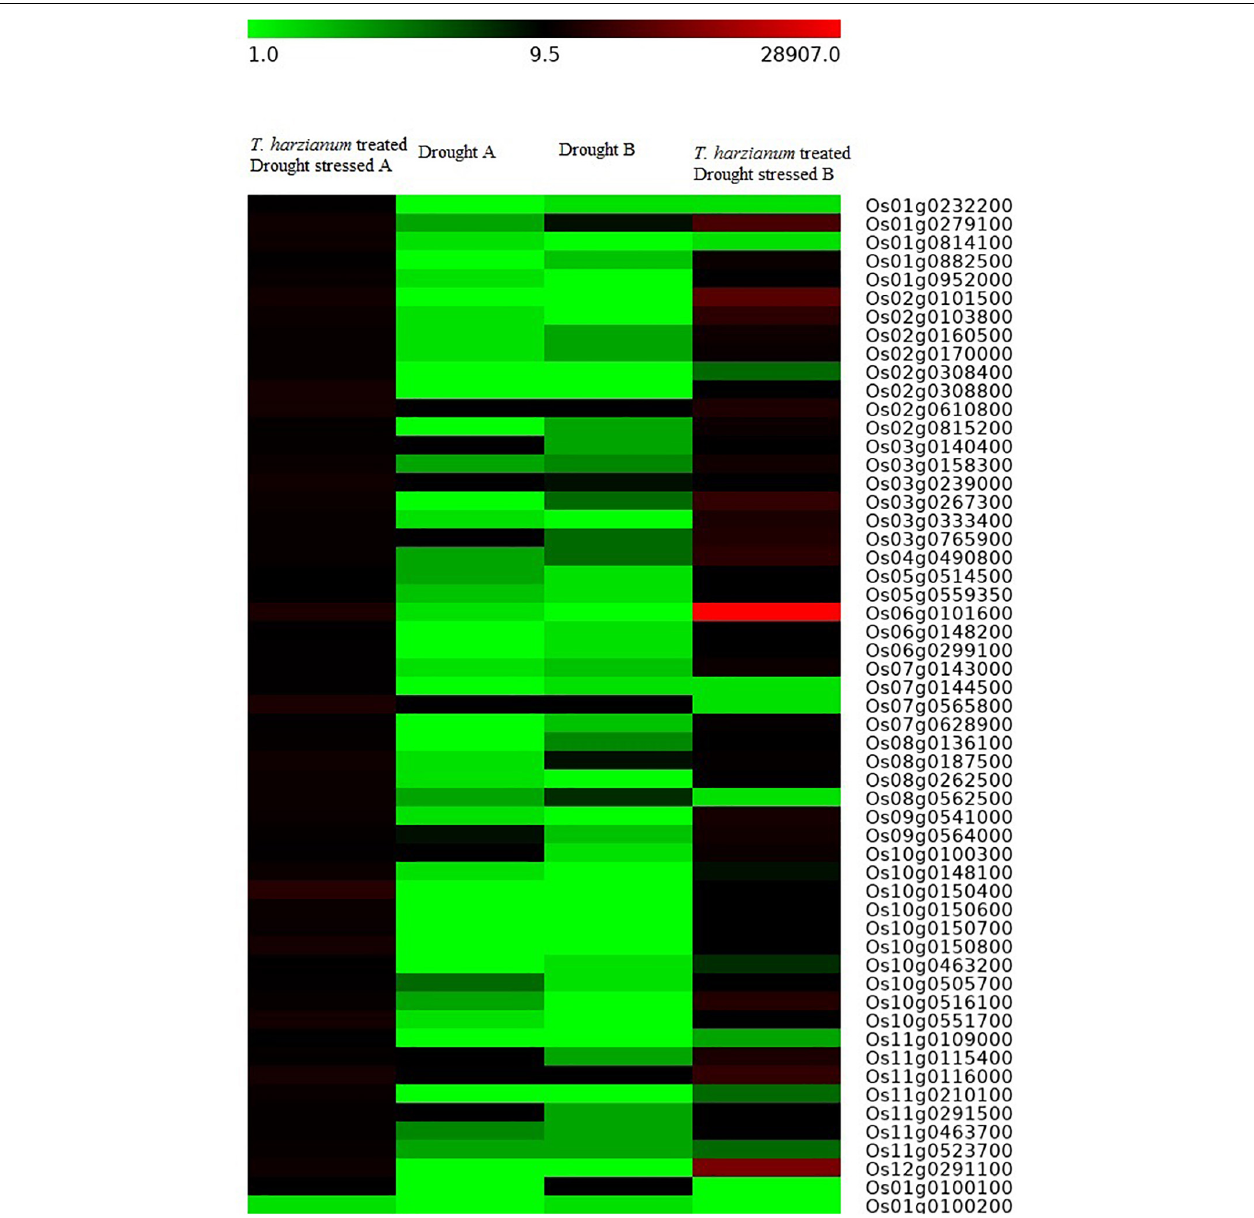
FIGURE 3 | Heat map with cluster categorization representing the top 50 significant DEGs at two different comparisons of treatments ( T. harzianum -treated + drought-stressed, drought-stressed). Each column represents the DEGs in different samples with two replicates. The red color shows upregulated genes and the green color represents downregulated genes based on highest FPKM values. Each row represents an individual transcript.